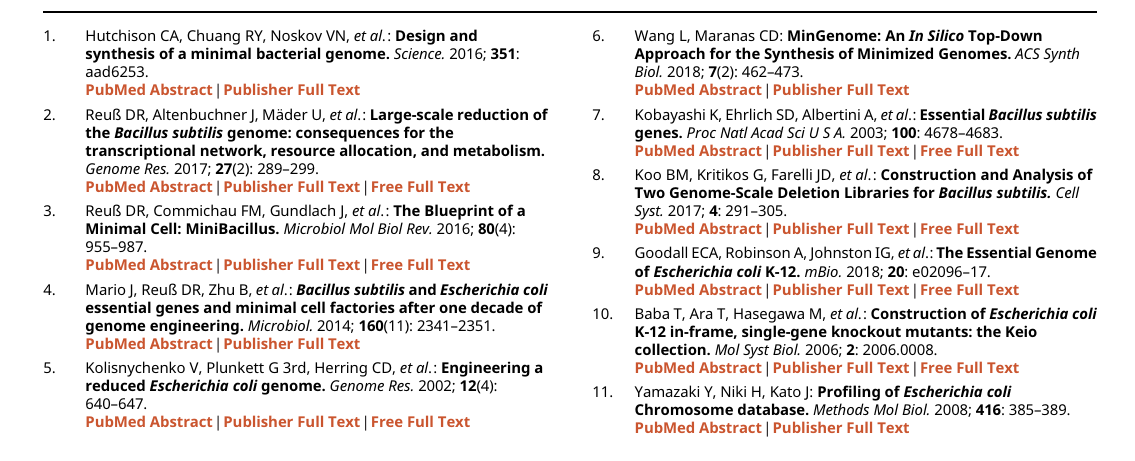
(cid:129) Supplementary Table 1 (cid:129) Supplementary Table 2 (cid:129) Supplementary Table 3 (cid:129) Supplementary Table 4 (cid:129) Supplementary Table 5 (cid:129) Supplementary Table 6 (cid:129) Supplementary Table 7 (cid:129) Supplementary Table 8 (cid:129) Supplementary Table 9 (cid:129) Supplementary Table